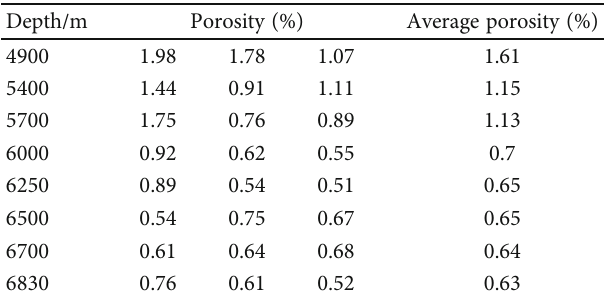
Table 5: Porosity measured by the water saturated drying method.